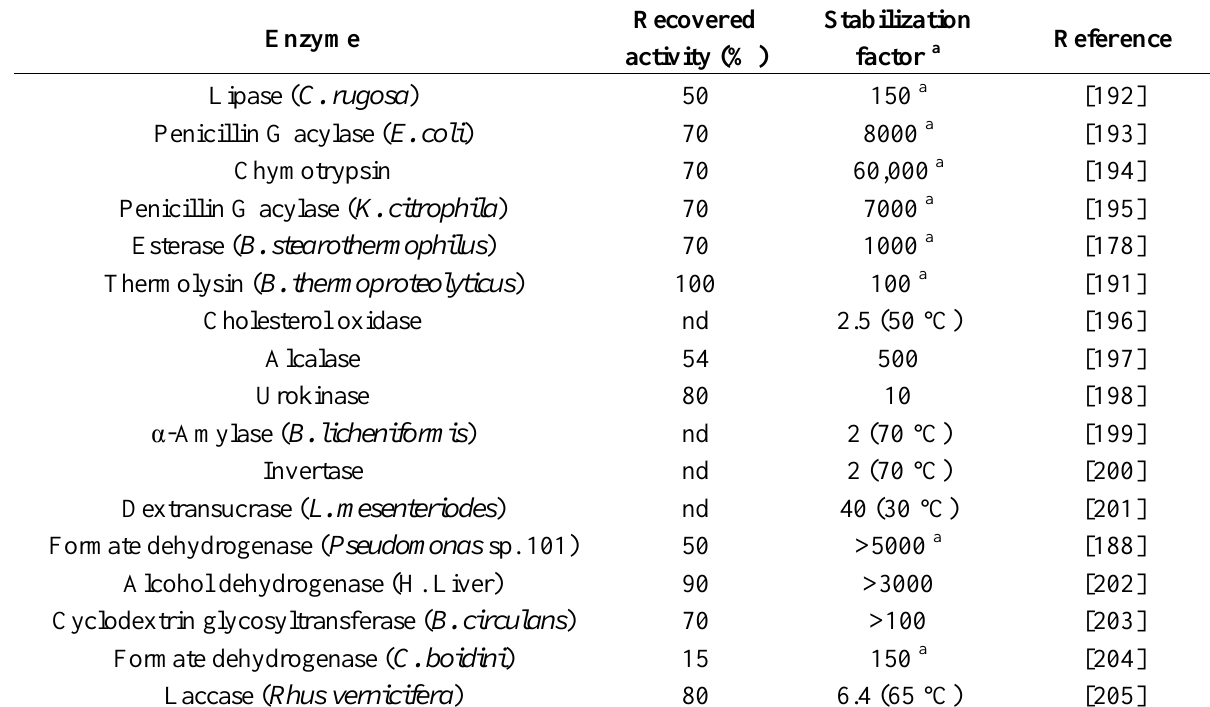
Table 3. Examples of enzyme stabilization by